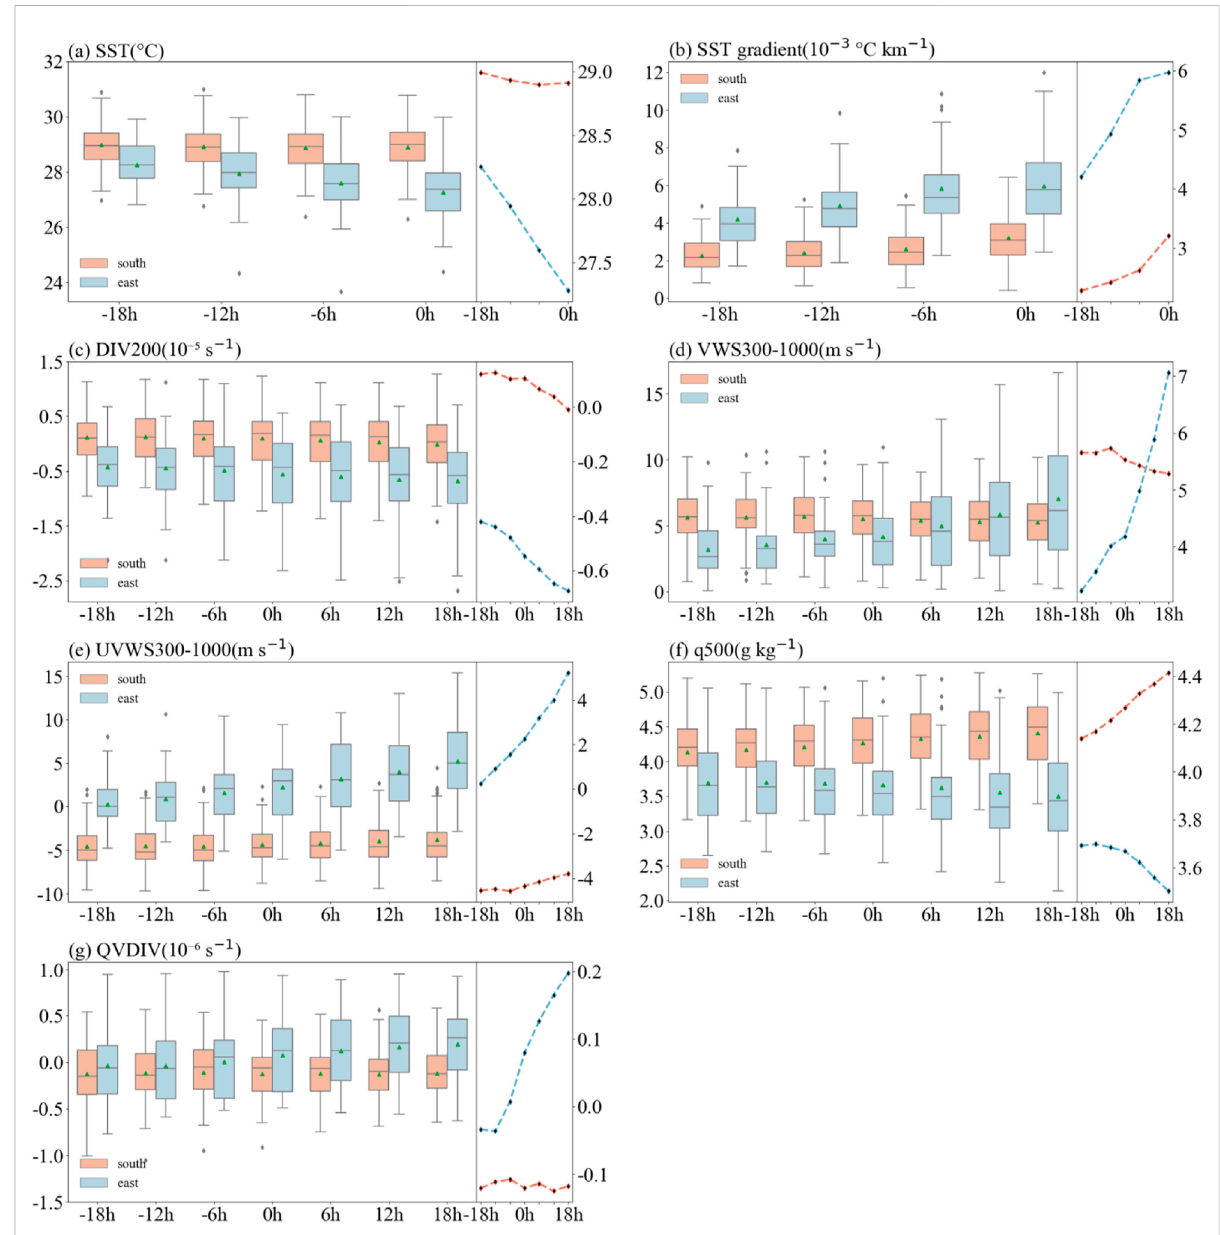
FIGURE 6 Evolutions of (A) SST ( ° C), (B) SST gradient (10 − 3 ° C km − 1 ), (C) divergence at 200 hPa (10 − 5 s − 1 ), (D) vertical wind shear (m s − 1 ) between 1000 hPa and 300 hPa, (E) zonal vertical wind shear (m s − 1 )between1000 hPa and 300 hPa, (F) speci fi chumidity (gkg − 1 )at500 hPa, (G) low-level water vapor fl ux divergence (10 − 6 s − 1 ) between 1000 hPa and 850 hPa during TC landfall over East China (red) and South China (blue). Green dots and horizontal linesrepresentmeanvalueandmedianlines,respectively. Rightpartineachpanelrepresentstheevolutionofthecorrespondingmeanvalueof the factor over East China (red) and South China